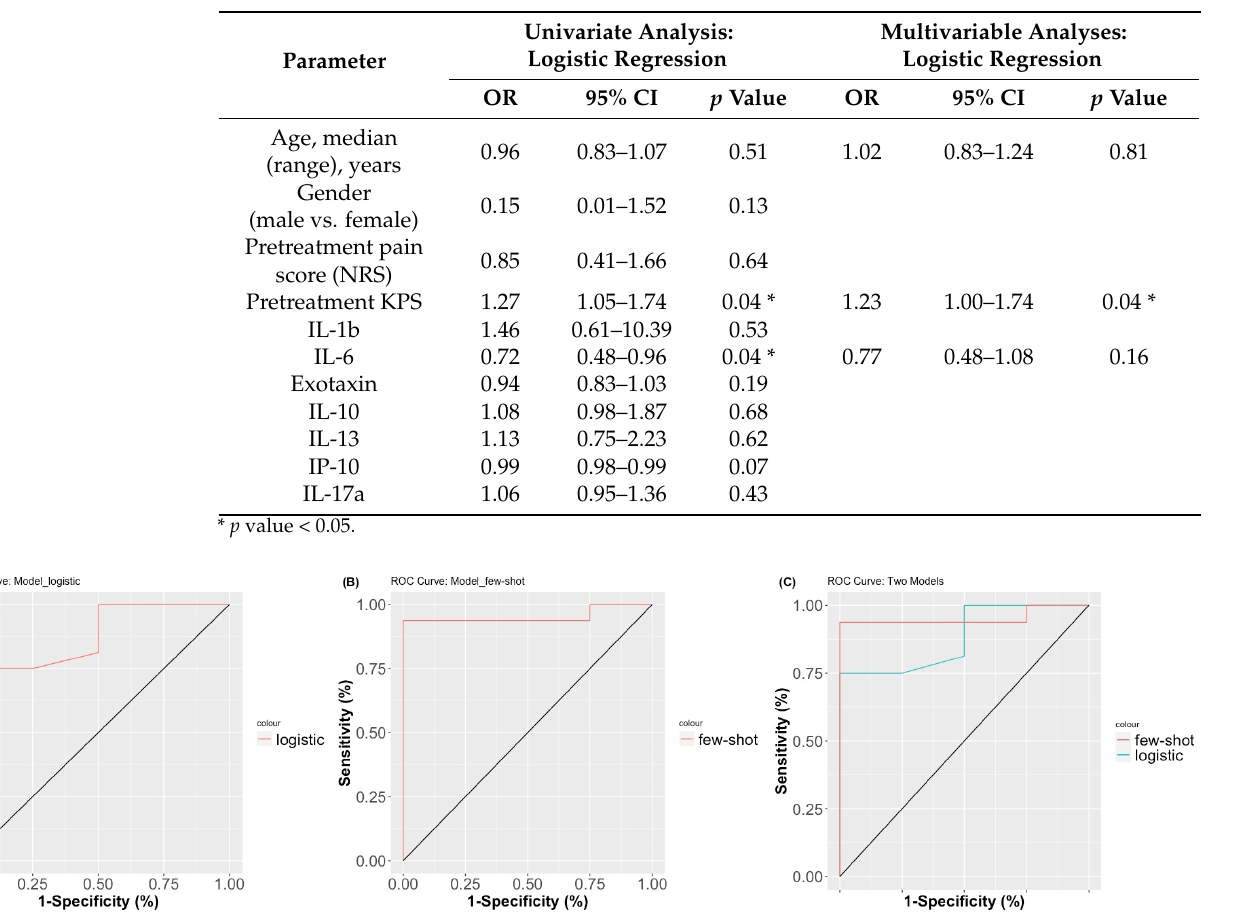
Table 4. Univariate and multivariate analyses of parameters for prediction of clinical responses to MRgFUS.